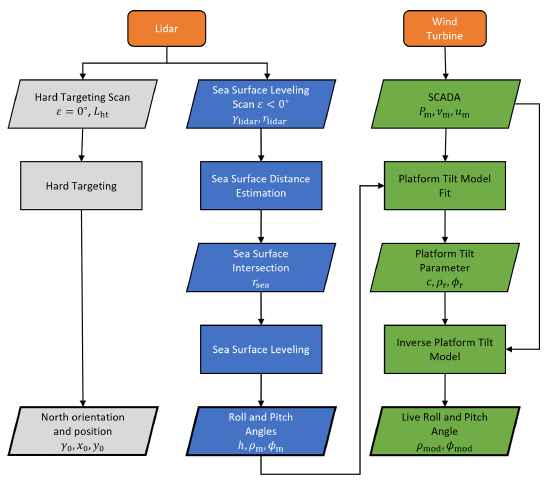
Figure 1. Overview of the procedure of the methods. In orange are the input devices. HT is shown in grey, SSL in blue and PTM in green. The variables are explained in the following sections.